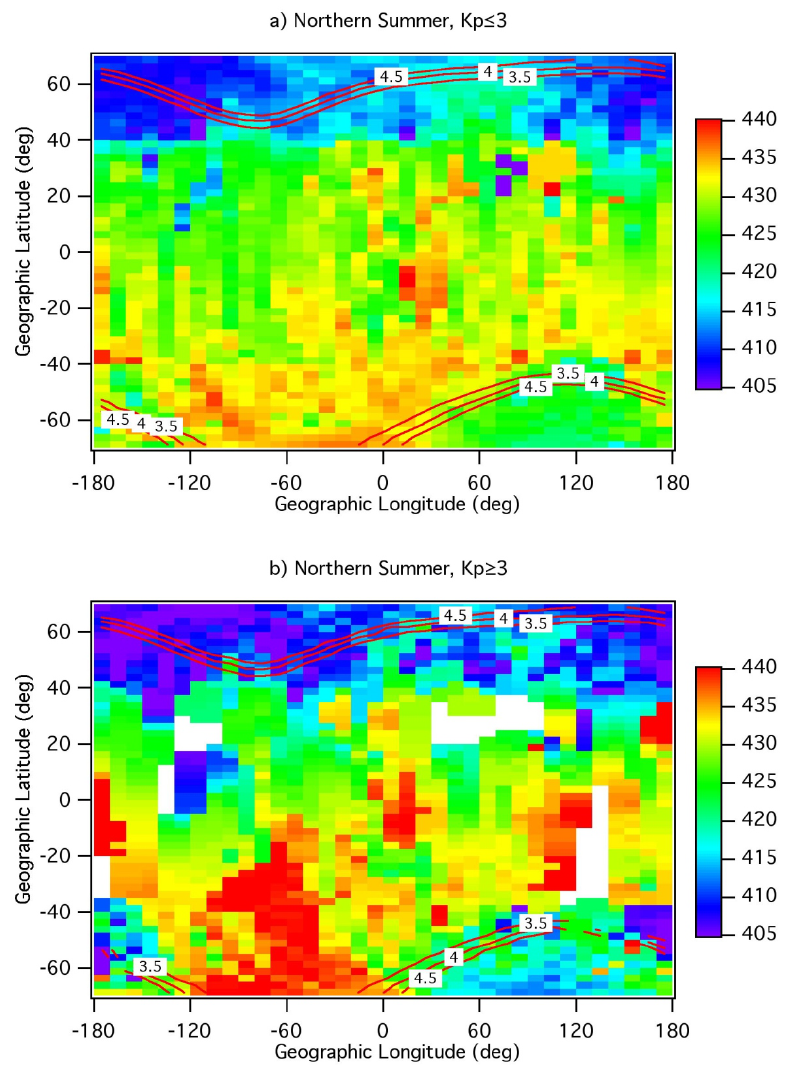
Fig. 3. AE-C: Maps of P -parameter for northern summer for (a) quiet magnetic conditions ( K p ≤ 3 above) and (b) disturbed magnetic conditions ( K p ≥ 3, below). Red curves show magnetic L